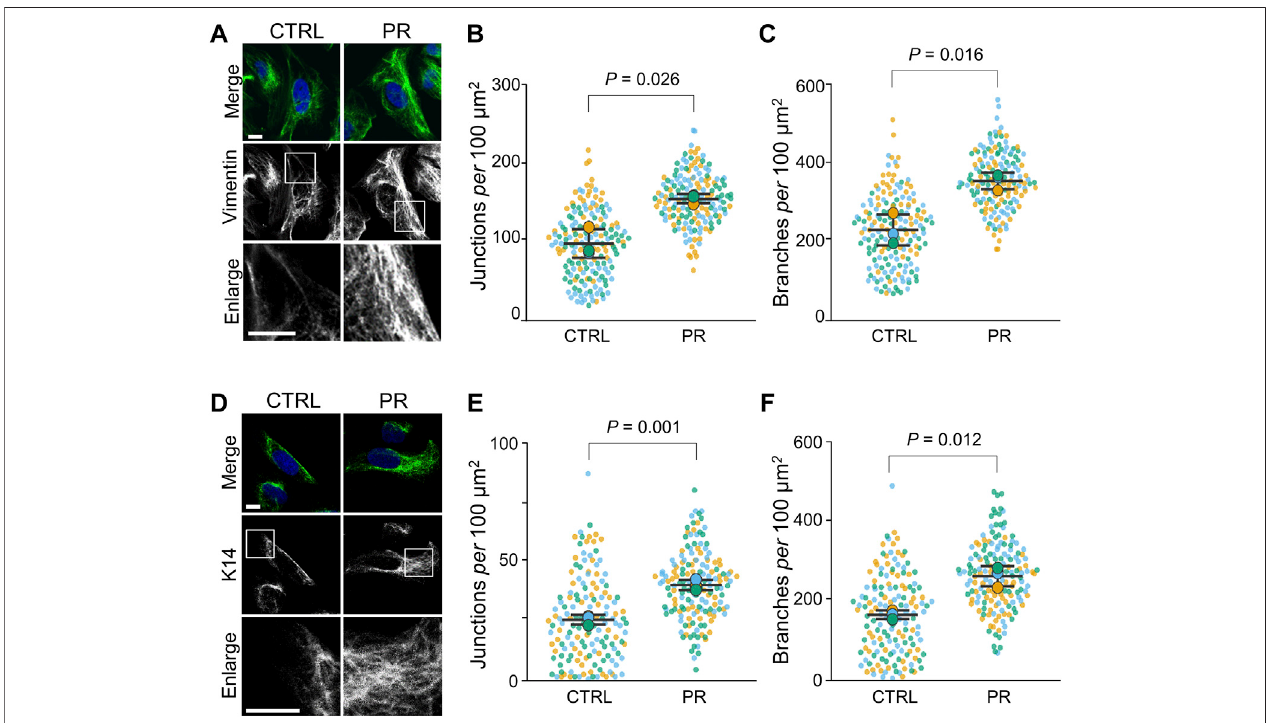
FIGURE 1 | PR poly-dipeptides (PR 20 ) change the organization of intermediate fi laments (IF) of U2OS cells. (A) Fluorescent images of Vim-IFs in untreated control (CTRL) and PR 20 -treated (PR) cells. Vim-IFs (green) and DAPI (blue) are shown. Scale bars are 10 µm. (B,C) Quanti fi cation of Vim-IF junctions (in B) and branches (in C) per 100 μ m 2 in the cytoplasm in CTRL and PR cells. Bars are means ± SD. In each experiment, 50 to 60 cells were evaluated ( n = 3). P value shows Welch ’ s t -test. (D) Fluorescent images of cytokeratin14 (K14) in CTRL and PR cells. K14 (green) and DAPI (blue) are shown. Scale bars are 10 µm. (E,F) Quanti fi cation of Keratin-IF junctions(inE)andbranches(inF)per100 μ m 2 inthecytoplasminCTRLandPRcells.Barsaremeans±SD.Ineach experiment, 50to58cellswereevaluated( n =3). p value shows Welch ’ s t -test. In quanti fi cation graphs, small dots are individual datapoints, and large dots indicate the averagesof each experiment in orange ( fi rst; n = 1), blue (second; n = 2) and green (third; n = 3), respectively.